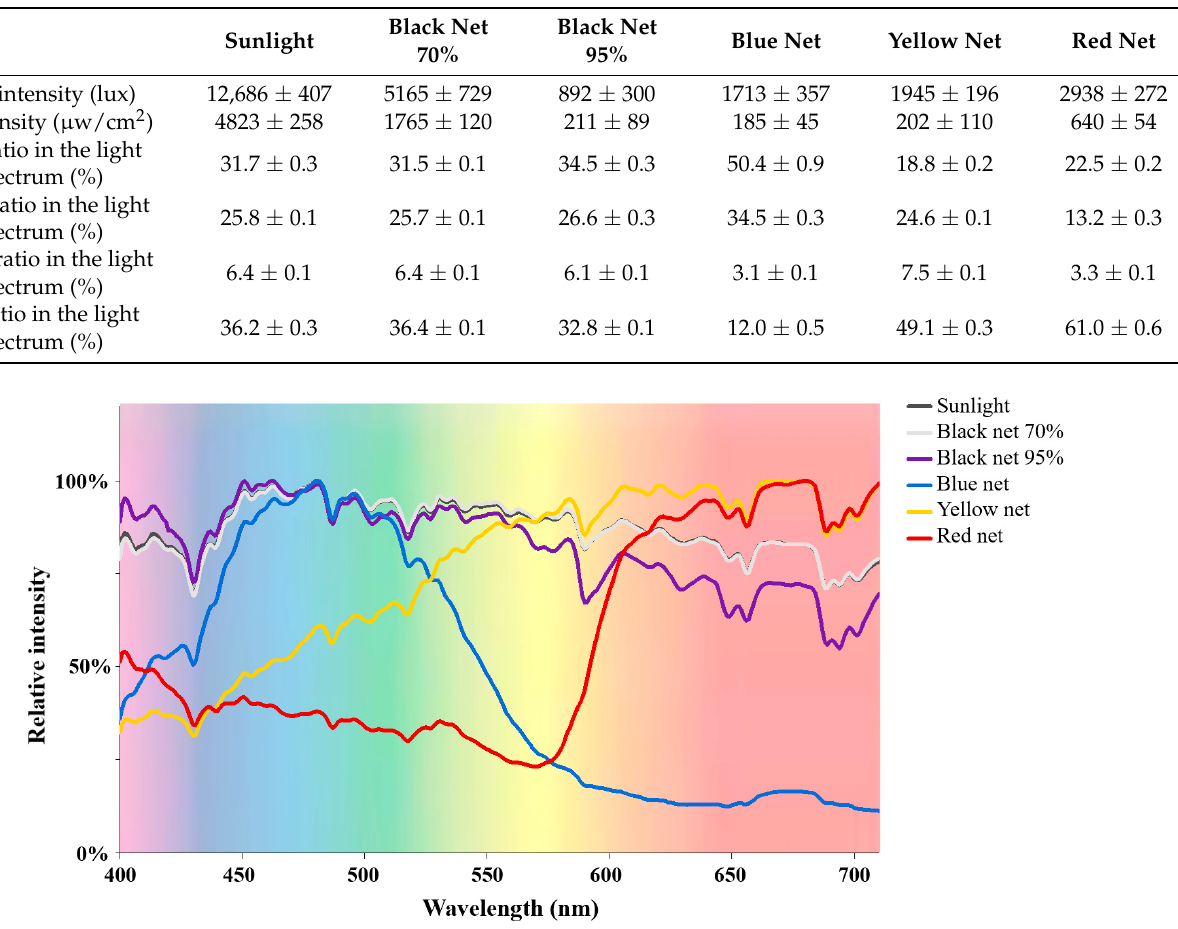
Figure 1. The light spectrograms under different shade